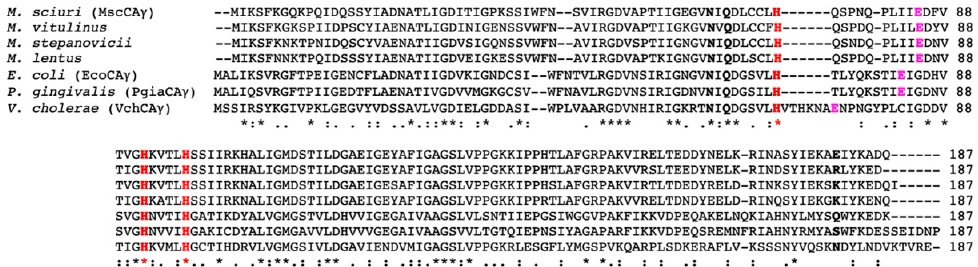
Figure 1. An alignment of the amino acid sequences of the γ -CAs from different bacterial sources, such as M . sciuri , M. vitulinus , M. stepanovicii , M. lentus , E. coli, P. gingivalis , and V. cholerae . The γ -CA hallmarks, such as the metal ion ligands, the residues which participate in a network of hydro- gen bonds, and the proton shuttle residue, are shown in red bold, black bold, and violet bold, respectively. The asterisk (*) indicates identity at all aligned, the symbol (:) relates to conserved substitutions, while (.) means semi-conserved substitutions.